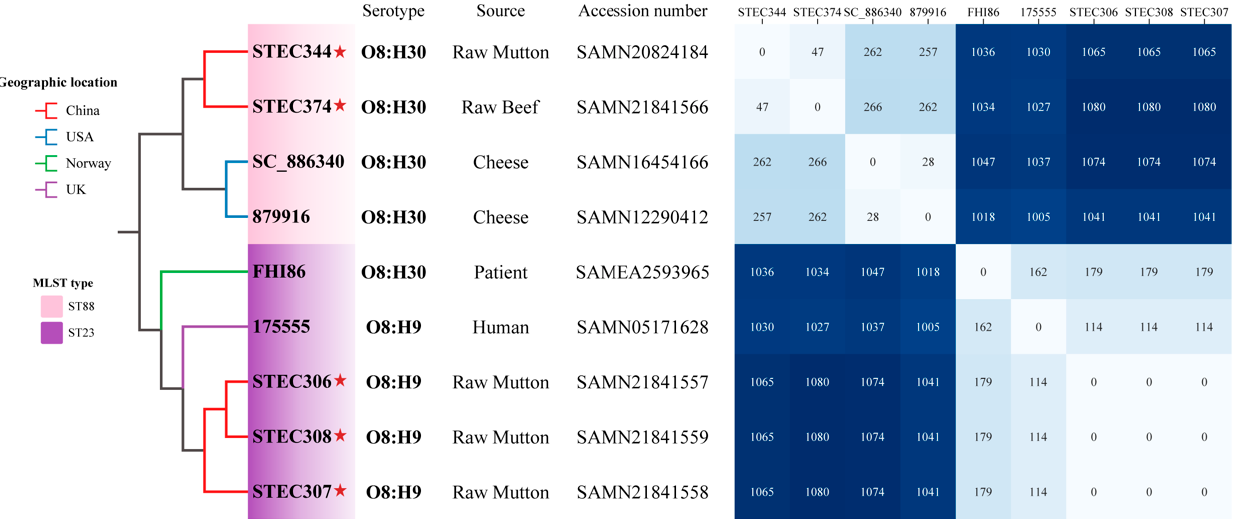
Figure 3. Phylogenetic tree based on single ‐ nucleotide polymorphisms (SNPs) using the Maximum ‐ Likelihood method. Branch length is ignored for better visualization. The red stars indicate strains in this study. The geographic location, MLST type, serotype, source, and accession number of all strains are shown. The heatmap illustrates pairwise SNP distances between the Stx2l ‐ STEC strains.